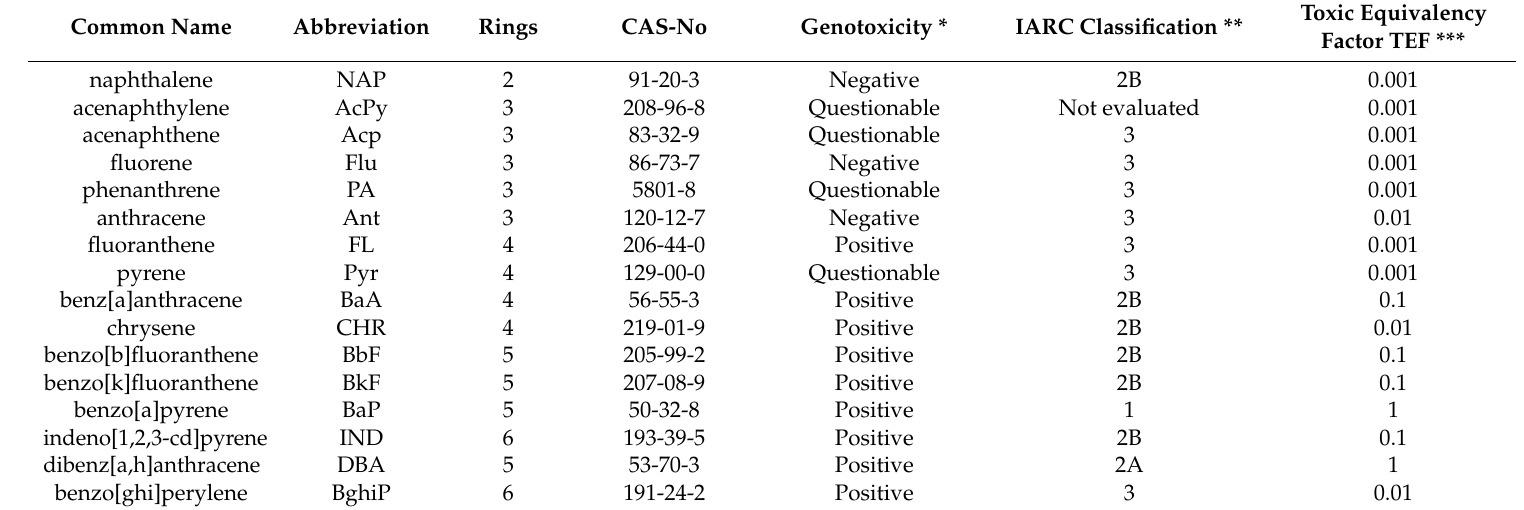
Table 2. A list of polycyclic aromatic hydrocarbons (PAHs) with carcinogenic potency and their toxicity